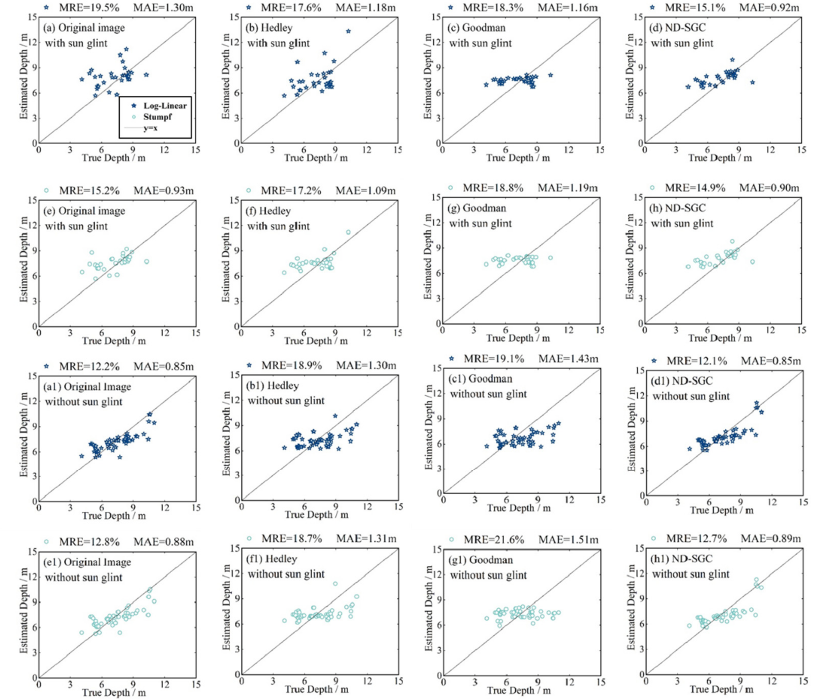
Figure 10. Bathymetric scatter plots of two bathymetric inversion models on the sun glint pixels and sun glint-free pixels of Tiexian Jiao, and the MRE and MAE of bathymetric inversion. ( a – d ) Log-Linear model bathymetric scatter plots on glint pixels from original image, Hedley’s method, Goodman’s method and ND-SGC method respectively; ( e – h ) Stumpf model bathymetric scatter plots on glint pixels from original image, Hedley’s method, Goodman’s method and ND-SGC method respectively; ( a1 – d1) Log-Linear model bathymetric scatter plots on glint-free pixels from original image, Hedley’s method, Goodman’s method and ND-SGC method respectively; ( e1 – h1 ) Stumpf model bathymetric scatter plots on glint-free pixels from original image, Hedley’s method, Goodman’s method and ND-SGC method